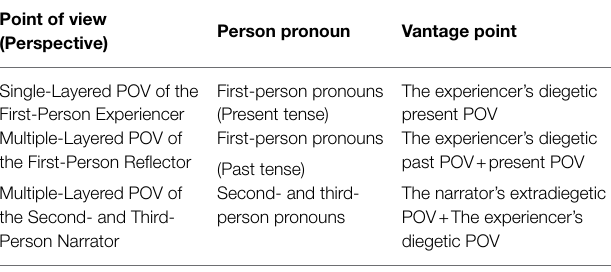
TABLE 1 | The relationship between person pronoun and point of